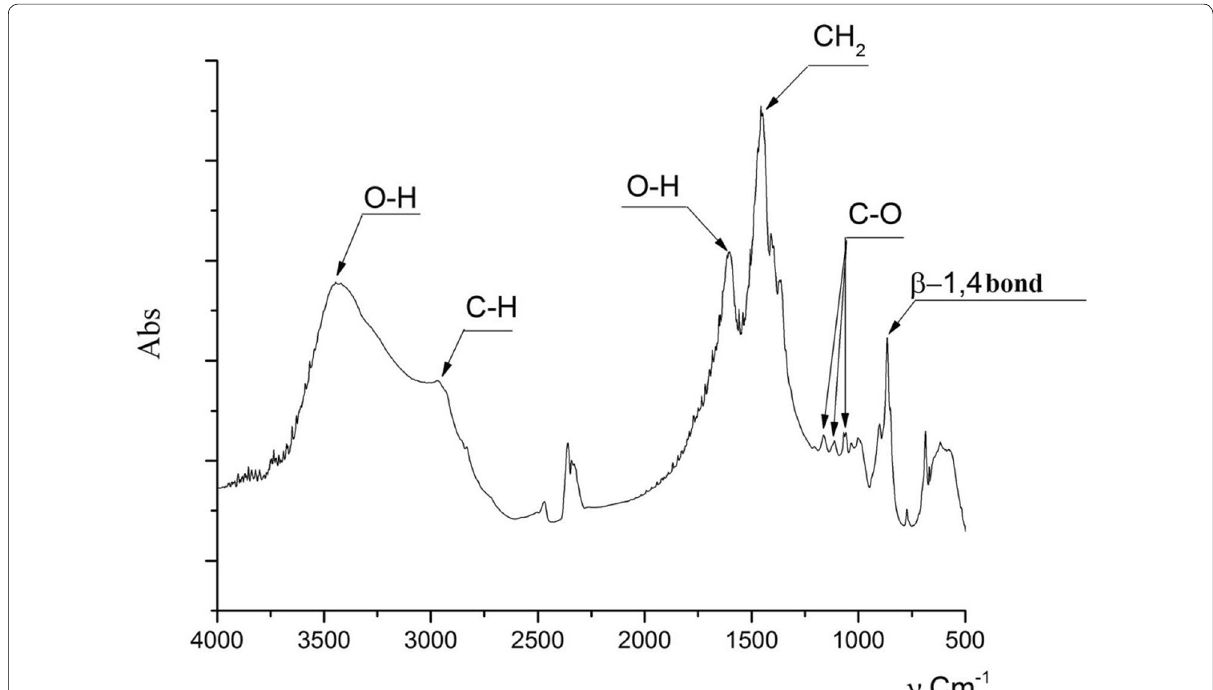
Fig. 6 FTIR spectrum of bacterial cellulose obtained under dynamic conditions on a molasses medium using producer immobilized